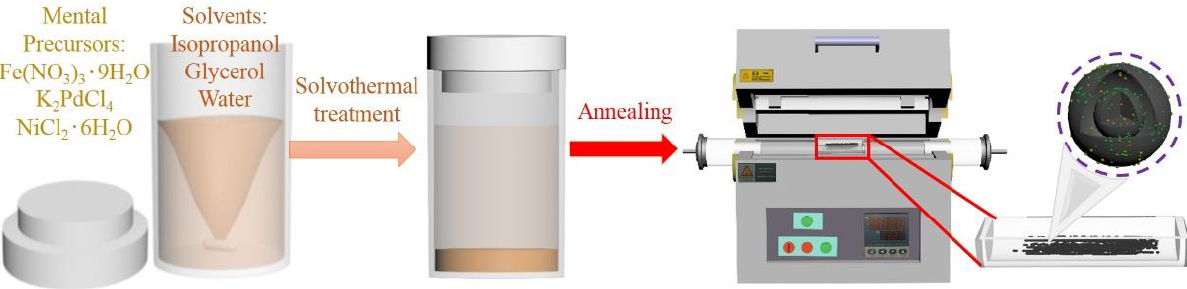
Figure 1. Schematic illustration of the preparation process of Ni-Pd/Fe 3 O 4 catalyst. The phase composition of the synthesized Ni-Pd/Fe 3 O 4 catalyst was confirmed by X-ray diffraction (XRD). As illustrated in Figure 2a, the characteristic peaks at 18.3 ◦ , 30.1 ◦ , 35.5 ◦ 43.1 ◦ , 57.1 ◦ , and 62.6 ◦ match well with the (011), (112), (103), (004), (321), and (224) re- flections of Fe 3 O 4 (JCPDS No. 01-075-1609), respectively. We note the absence of metallic Ni and Pd peaks in the XRD patterns of the Ni-Pd/Fe 3 O 4 sample, which should be attributed to the small size and low loading of Ni and Pd incorporated in the Fe 3 O 4 support. In addition, the morphology of the synthesized Ni-Pd/Fe 3 O 4 nanocatalysts was characterized by scanning electron microscopy (SEM). As can be seen from the SEM images, Ni-Pd/Fe 3 O 4 presents a spherical nanostructure with a diameter of 500–800 nm (Figure 2b,c). Transmis- sion electron microscopy (TEM) and aberration-corrected high-angle annular dark-field scanning transmission electron microscopy (HAADF-STEM) images further confirmed the spherical yolk-shelled structure. A yolk-like core was encapsulated in the thin shell for each Ni-Pd/Fe 3 O 4 nanosphere (Figure 3a). The shell thickness of the Ni-Pd/Fe 3 O 4 particles is about 60 nm, consisting of stacked tiny nanoparticles (Figure 3b,c), leading to the formation of a porous structure. In comparison, the pristine Fe 3 O 4 nanospheres prepared without the Ni and Pd precursor show a hollow nanospherical structure (Figure S1). The STEM images and the energy dispersive X-ray (EDX) elemental mapping show that the Ni and Pd elements are uniformly distributed across the Fe 3 O 4 nanospheres (Figure 3d–h). However, the crystallization degree of the Fe 3 O 4 support is not high enough to discrimi- nate Ni or Pd Fe species from the lattice of the Fe 3 O 4 substrate (Figure S2). The SSA and porosity characteristics of the Ni-Pd/Fe 3 O 4 hollow spherical nanocatalyst were analyzed by N 2 adsorption–desorption measurements and determined via Brunauer–Emmett–Teller (BET) and Barrett–Joyner–Halenda (BJH) methods. The H2-type N 2 adsorption–desorption isotherm exhibited a distinct hysteresis loop in the desorption branch. The SSA for the Ni-Pd/Fe 3 O 4 was 140.4 m 2 g − 1 , and the size of the pores (e.g., micropore and mesopore) mainly fall in the range from 1.5 to 10 nm (Figure